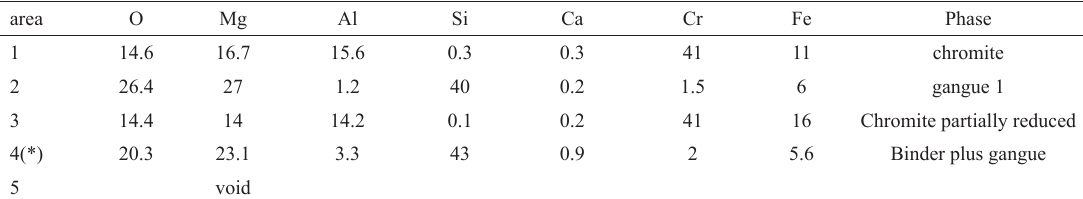
Table 5: Chemical composition in the core of the P7 pellet analyzed by backscattered electrons by scanning electron microscopy after 1573 K (120 minutes) (wt%)